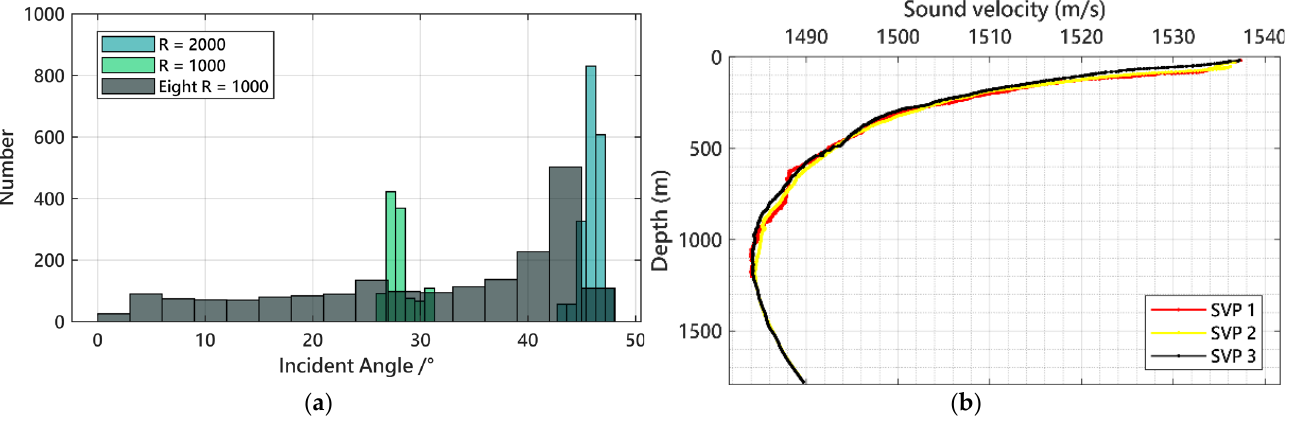
Figure 8. The incident histogram of the three trajectories ( a ). Sound velocity profiles of the water column during the GNSS/Acoustic survey ( b ).